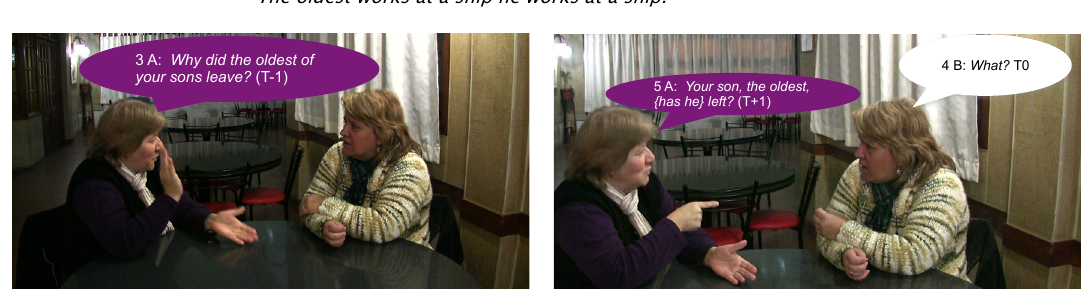
Figure 19. ‘What?’ , Person B (right) initiates repair on Person A’s prior turn with a wh-question word combined with eyeb- rows together, line 4,